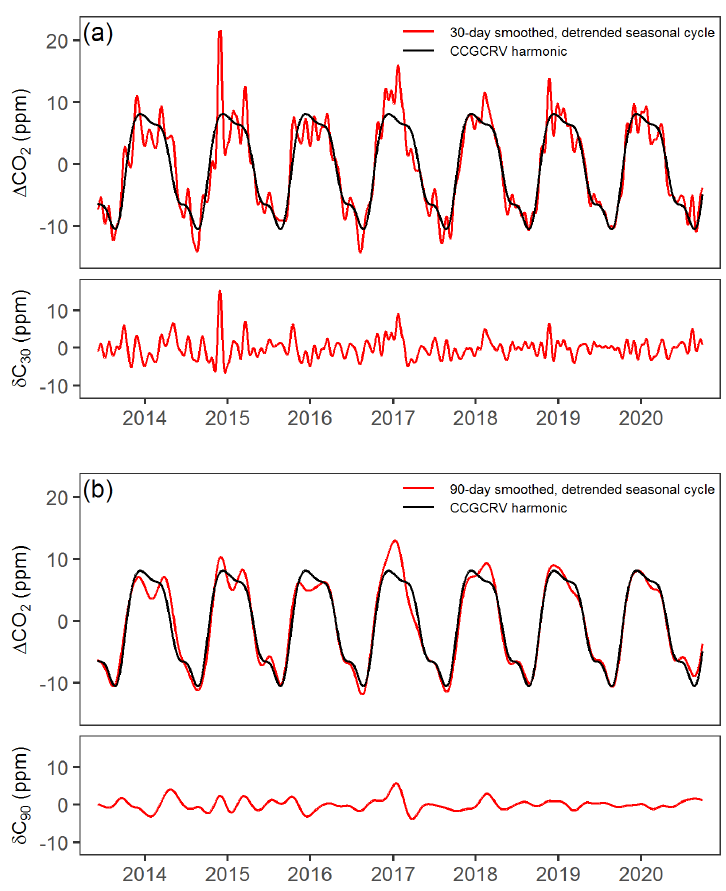
Figure 3. The smoothed, detrended seasonal cycle at TRN (red) extracted using (a) 30 and (b) 90d short-term filters of the CCGCRV function residuals. (cid:49) CO 2 represents the calculated mean seasonal variation in CO 2 , excluding the long-term trend.